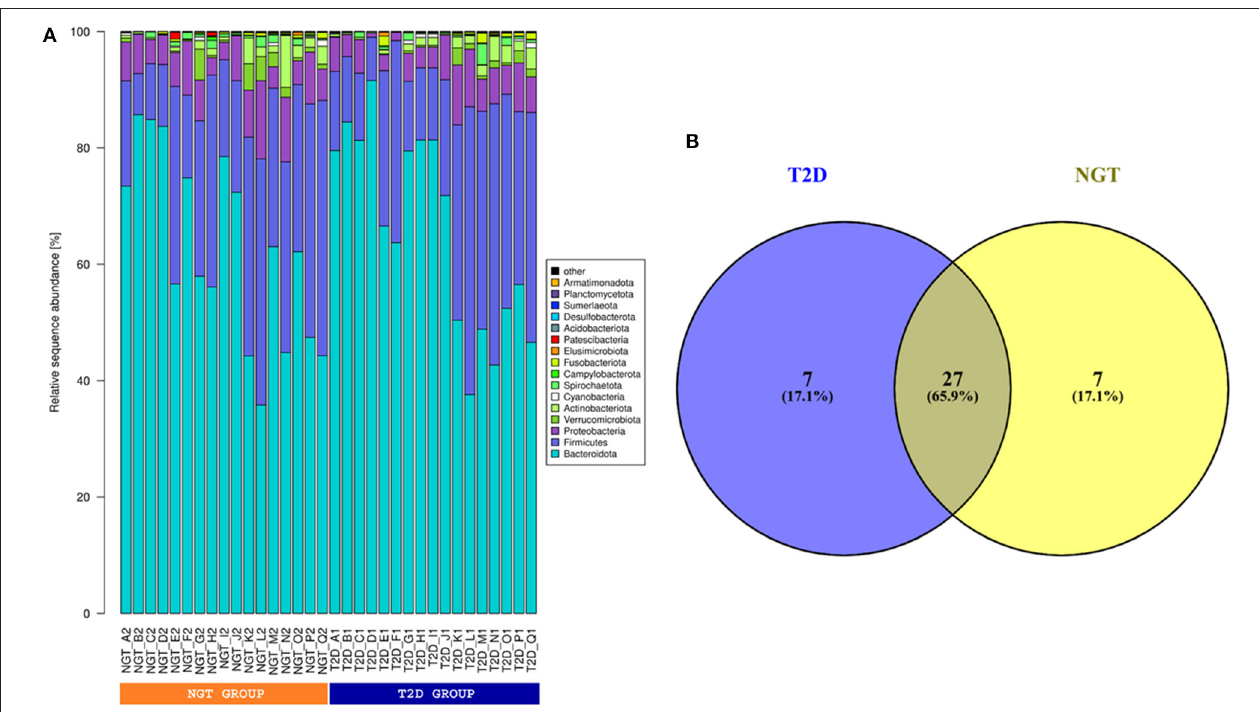
FIGURE 3 | (A) Phylum level taxonomic composition. Relative sequence abundance of most (top 10 based) dominant gut microbes in phylum level of studied samples. (B) Venn diagram for unique and common gut microbes. According to the Venn diagram, 27 gut microbes were common for both T2D and NGT groups, and 7 and 7 gut microbes were unique for T2D and NGT groups